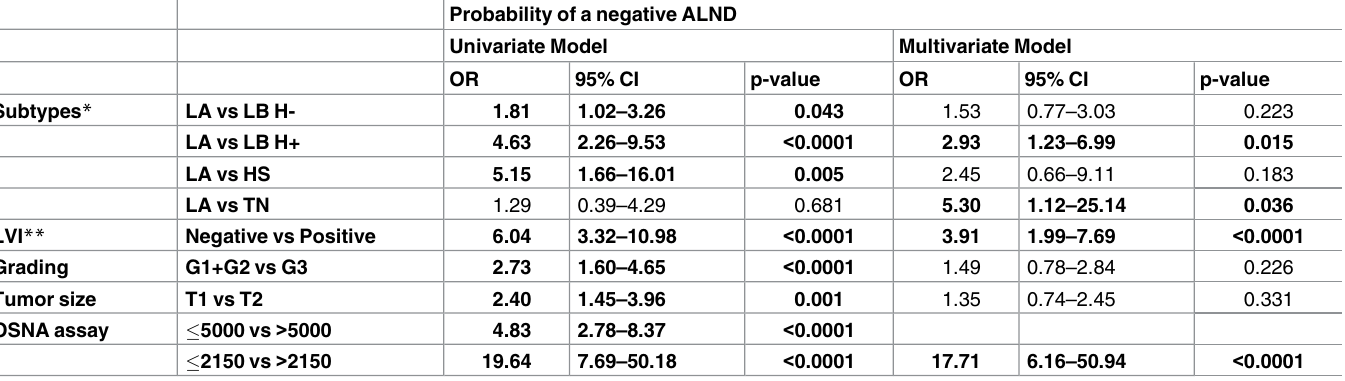
Table 5. Logistic regression analysis of variables that might predict non-sentinel node involvement in 318 patients with metastatic SLNs. Univari- ate and Multivariate analysis. Probability of a negative ALND Univariate Model Multivariate